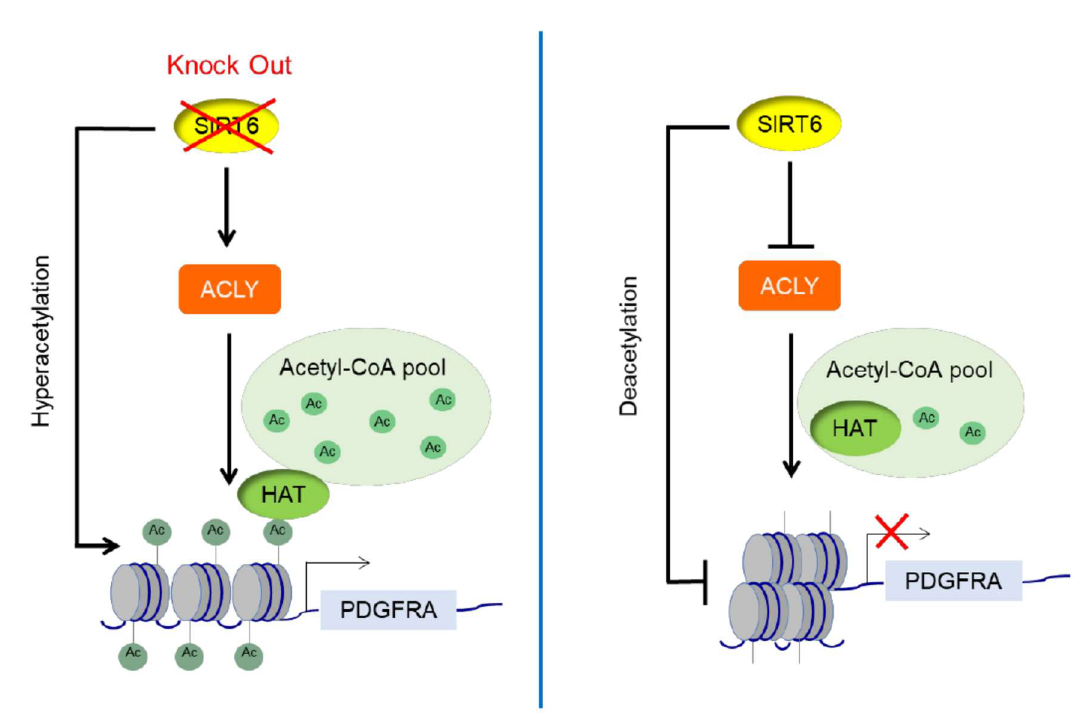
Figure 4. Model for the interplay between SIRT6 and ACLY, with a feed-forward loop to repress gene expression by coor- dinately regulating both histone deacetylation and availability of acetyl-CoA for histone acetylation.